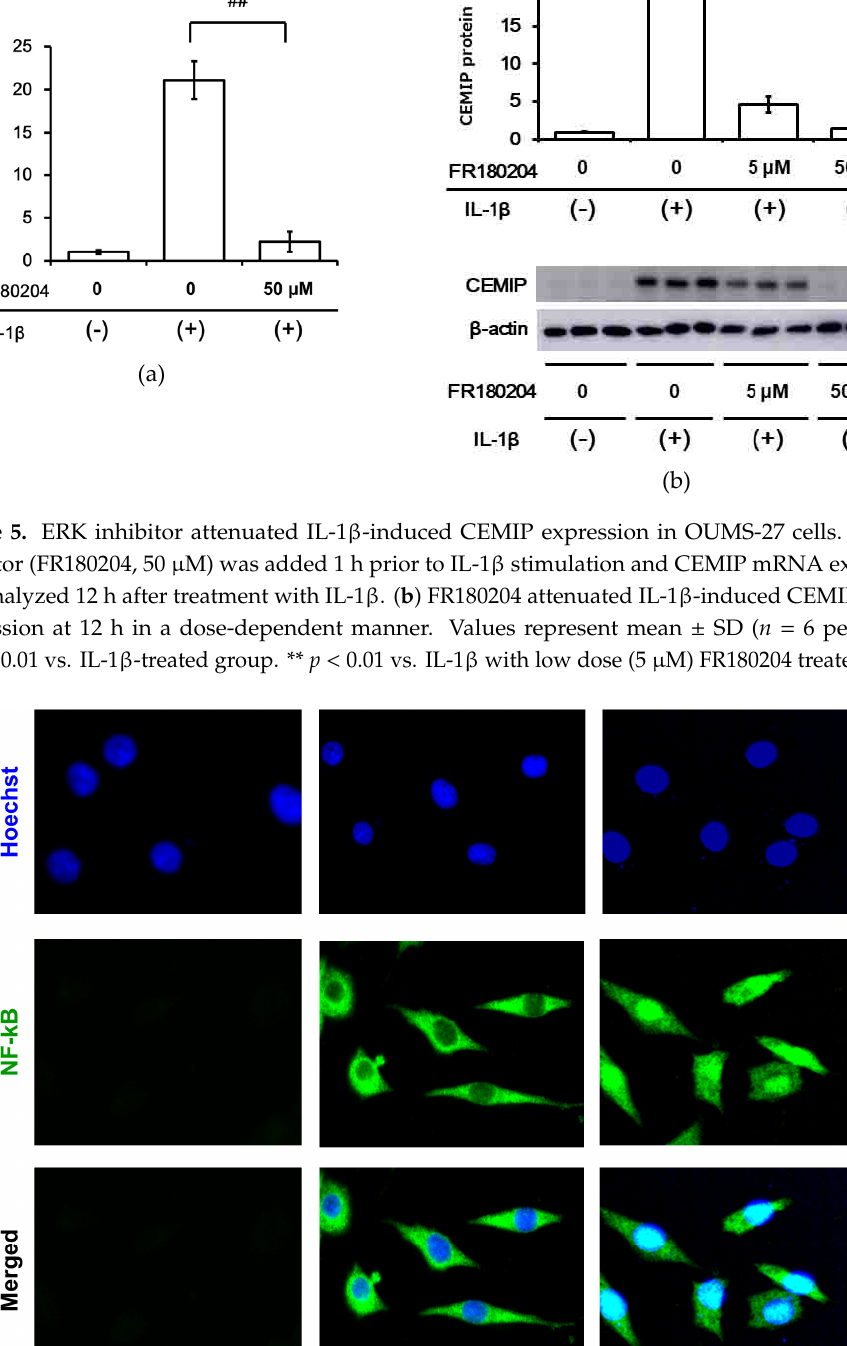
Figure 7. NF- κ B inhibitor (BAPTA-AM) attenuated IL-1 β -induced CEMIP expression. OUMS-27 cells were treated with IL-1 β for 12 h with or without 30 μ M BAPTA-AM. The CEMIP mRNA expression level was measured by qRT-PCR. Values represent mean ± SD ( n = 6 per group). ** p < 0.01 vs. control. ## p < 0.01 vs. IL-1 β with BAPTA-AM-treated group.